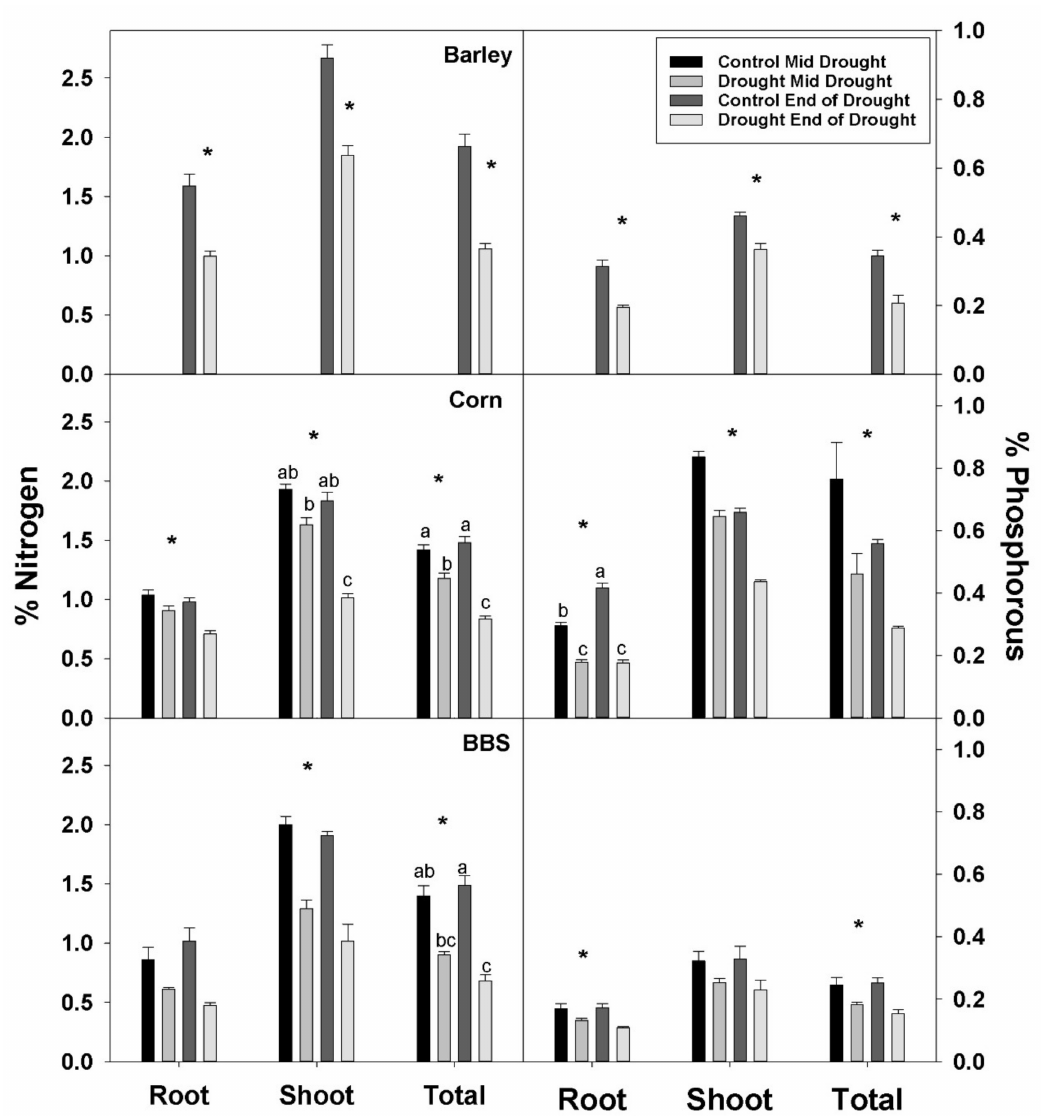
Figure 2. Effects of control vs. drought treatments on %N and %P per dry mass in root, shoot, and total plant tissue in barley, corn, and big bluestem (BBS). Each bar represents mean + 1 SE (standard error). Within each panel, bars not sharing the same letters are significantly different. For each response variable, significant effects of drought (ANOVA), across both harvest in corn and big bluestem, are indicated with an asterisk